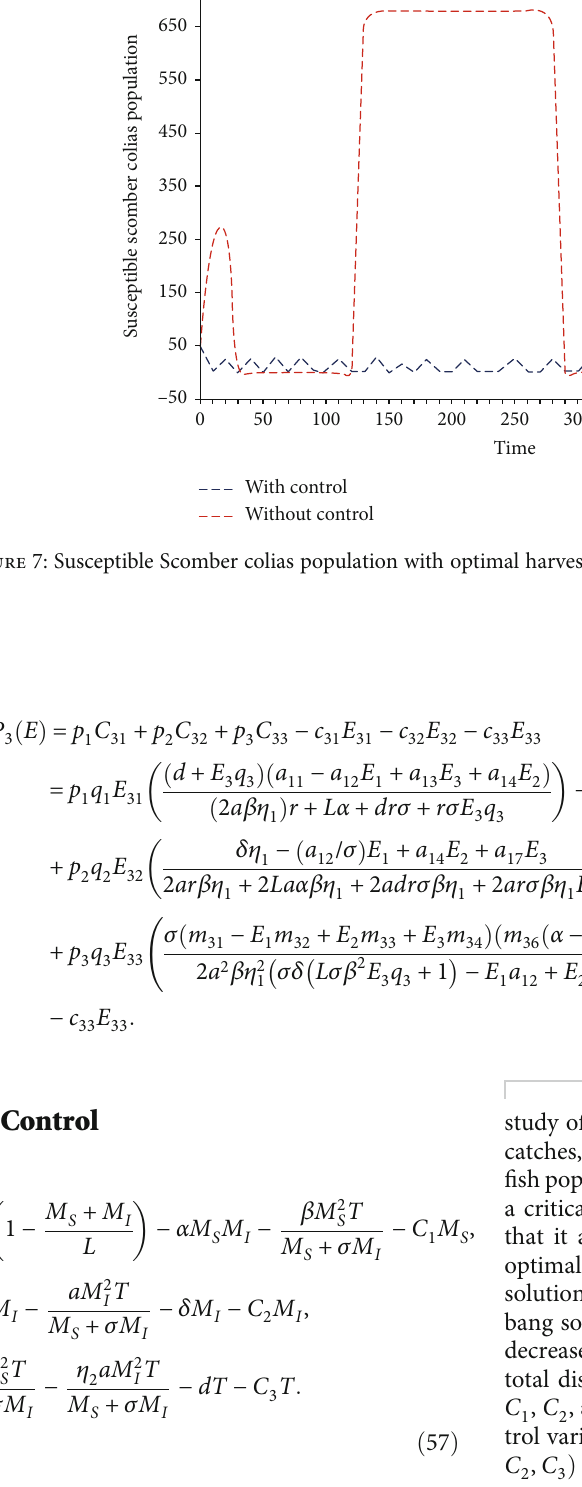
Figure 7: Susceptible Scomber colias population with optimal harvesting and e ff ort harvesting, with very low e ff ort.